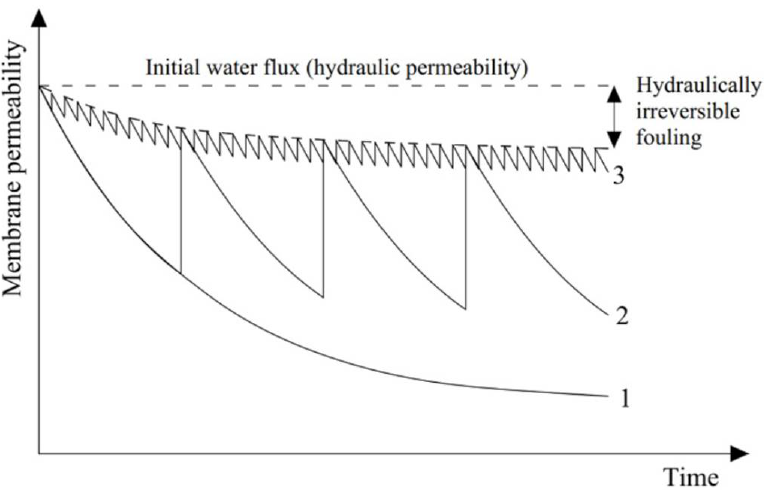
Figure 12. Depicts the effect of backpulsing and backwashing on membrane permeability decline: (1) filtration without backwashing or backpulsing, (2) filtration with backwashing, and (3) filtration with backpulsing. Both backpulsing and backwashing are assumed to be capable of completely removing hydraulically reversible fouling and to operate under reasonable conditions